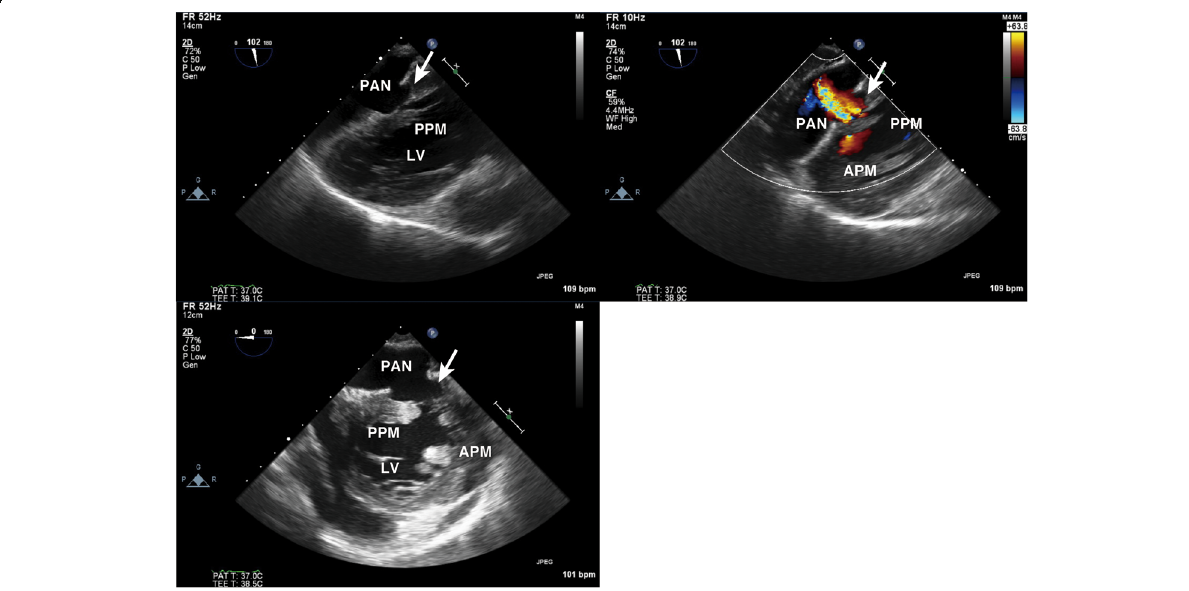
Fig. 1 Transgastric long-axis view (two-dimensional, upper left; color flow Doppler, upper right) and mid-papillary short-axis view (lower). The orifice of the pseudoaneurysm is located in the inferior wall of the left ventricle (arrow). APM anterolateral papillary muscle, LV left ventricle, PAN pseudoaneurysm, PPM posteromedial papillary